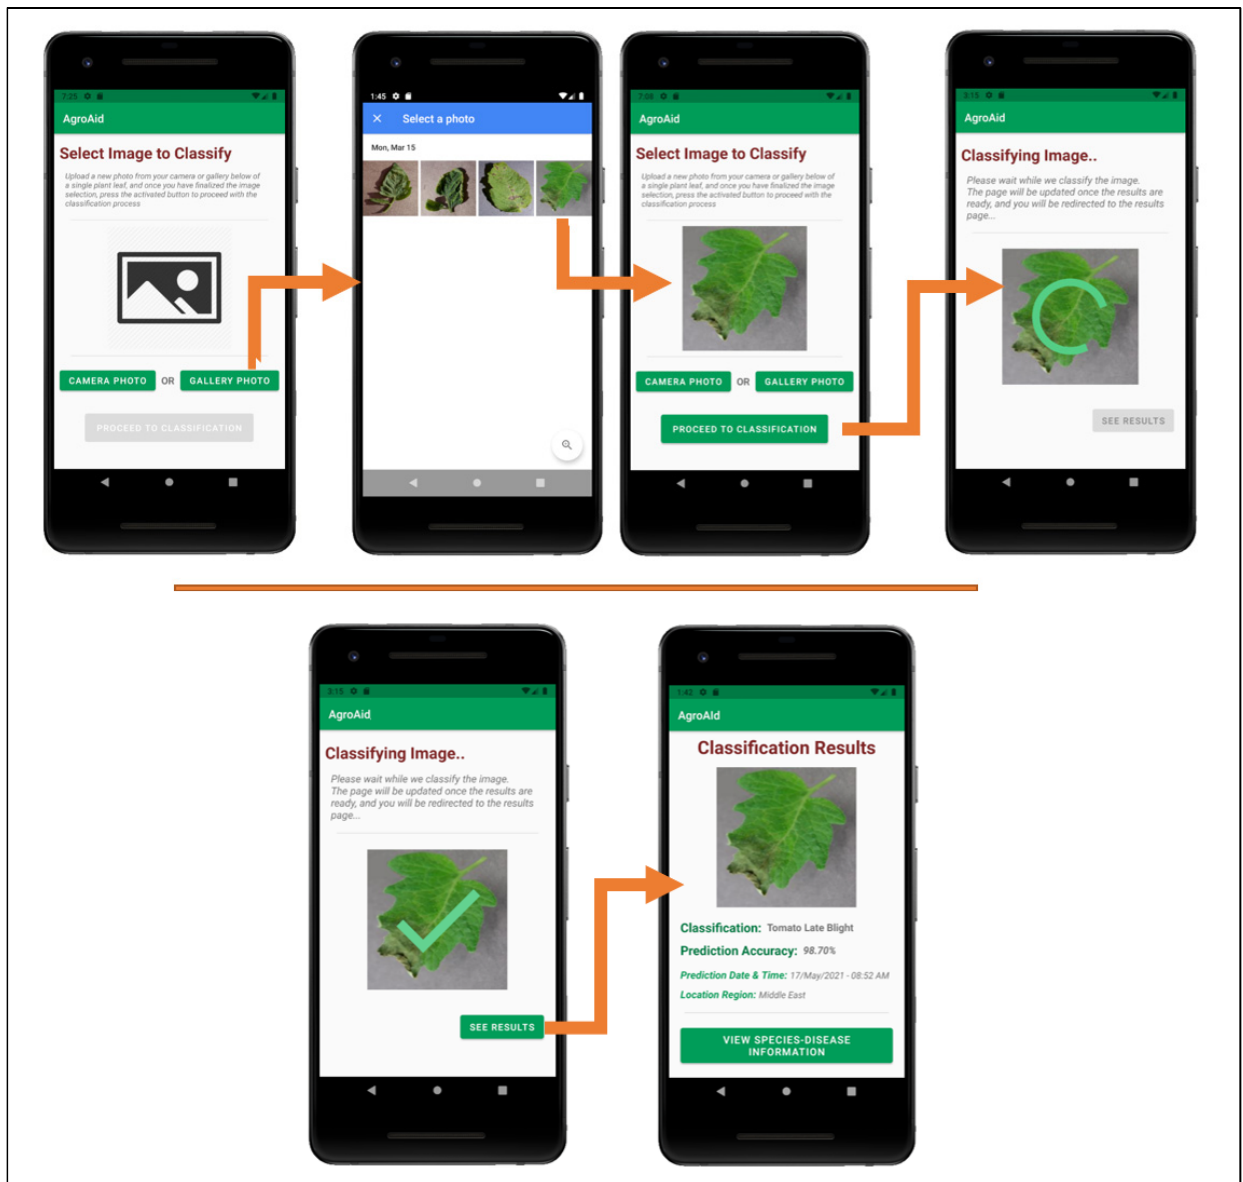
Figure 26. User-side walkthrough of the classification functionality of the system.